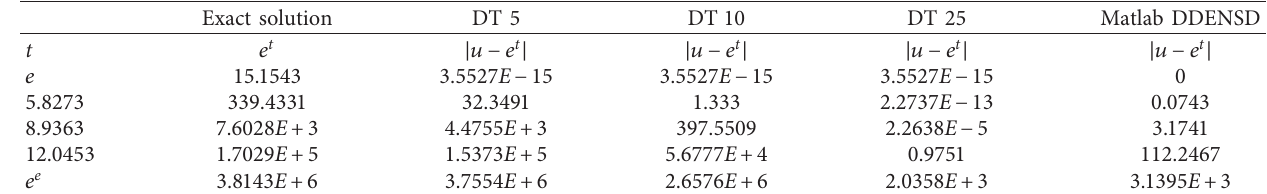
Table 2: Example 1, error analysis of u in [ e, e e ]